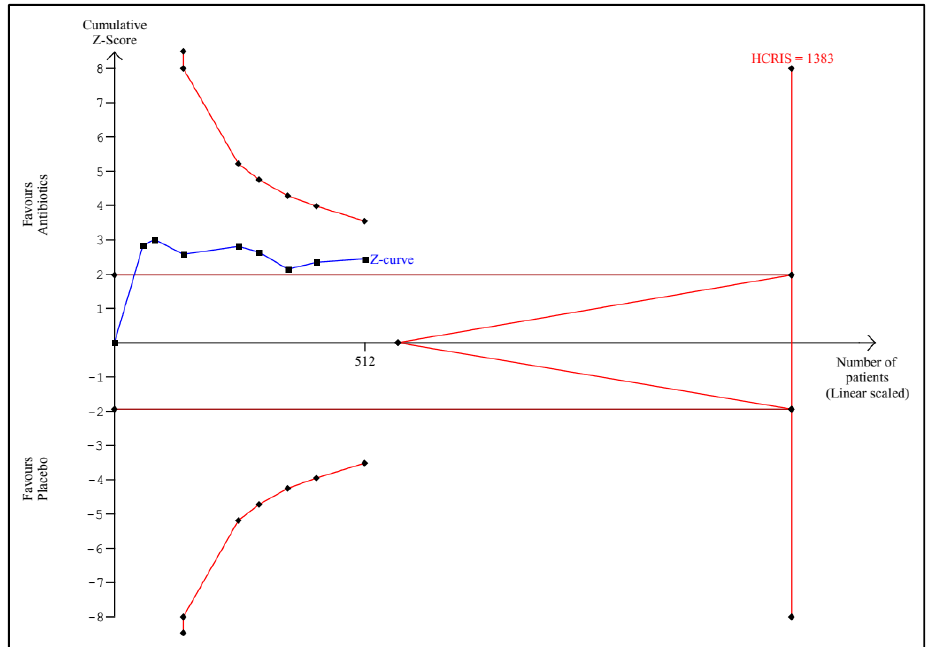
Figure 8. Trial sequential analysis for urinary tract infection. The HCRIS of 1383 patients was estimated based on an assumed incidence of this outcome in the control group of 20%, an RRR of 30%, an alpha of 5%, a beta of 20%, with a heterogeneity of 11%. A total of 512 patients (37% of the HCRIS) were randomized. The Z-curve crossed the conventional boundaries for p =0.05, but not the monitoring boundaries; HCRIS = heterogeneity-corrected required information size.